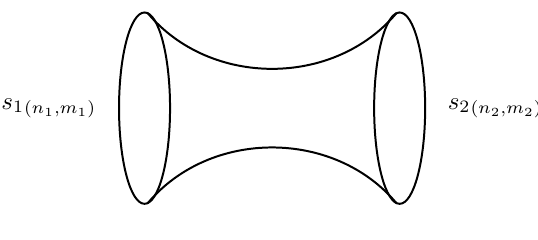
Figure 8 . The figure shows the cylinder amplitude we are computing between two FZZT boundaries with boundary cosmological constants µ B ( s 1 ) and µ B ( s 2 ) and matter boundary conditions labeled by ( n 1 , m 1 ) and ( n 2 , m 2 )